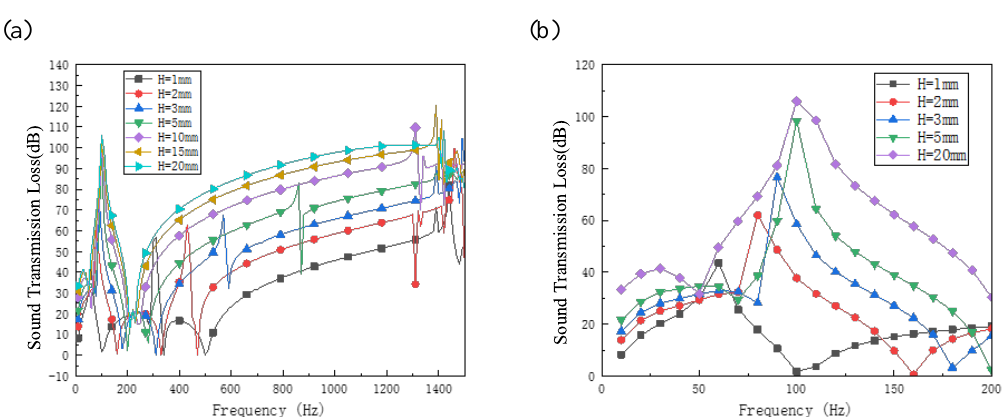
Figure 12. Effect of plate thickness on STL for a cavity thickness of 10 mm: ( a ) 0–1500 Hz and ( b ) 0– 200 Hz.